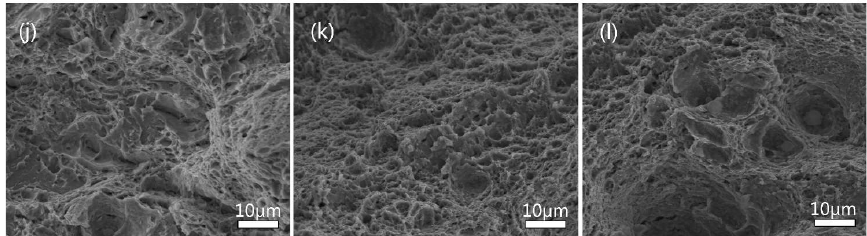
Figure 6. Macro fractographs of 42CrMo4-V steel tempered at ( a ) 570 °C; ( b ) 600 °C; ( c ) 630 °C; ( d ) 660 °C; ( e ) 690 °C; ( f ) 720 °C; ( g – i ) are high-magnification images of zone 1, 3 and 5 in ( a – f ), respectively, ( j – k ) are high-magnification images of zone 2, 4 and 6 in ( a – f ), respectively.